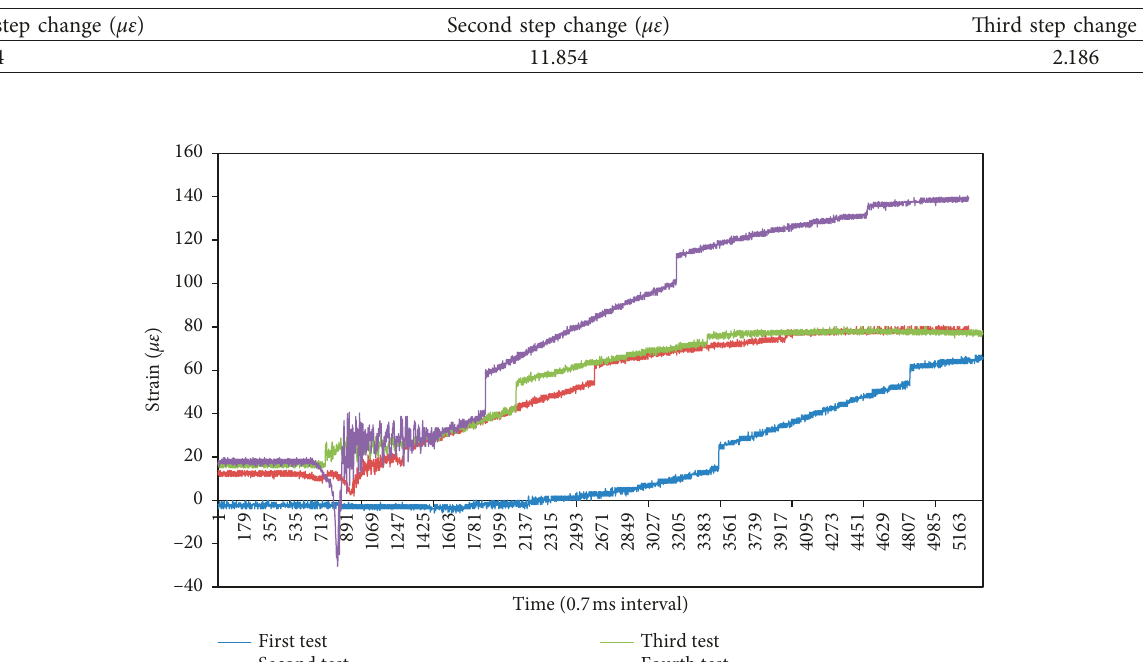
Figure 27: Explosion vent flame group in the fourth test. Table 4: Strain amplitude formed by the flame front in the fourth test.